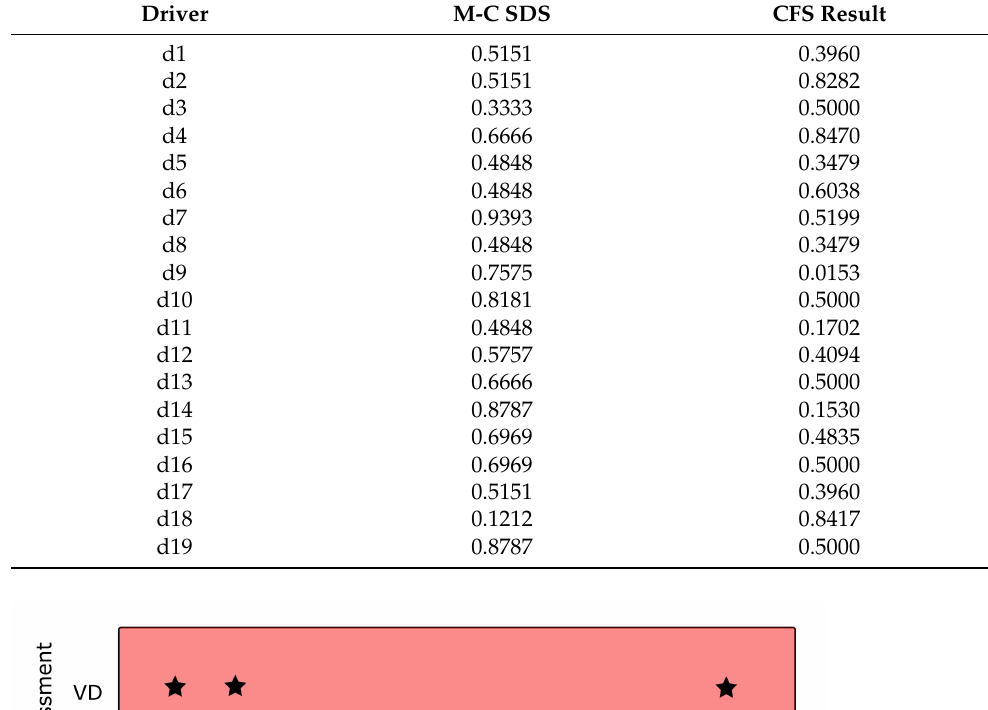
Table 9. Numerical results for Combined Fuzzy System (CFS).